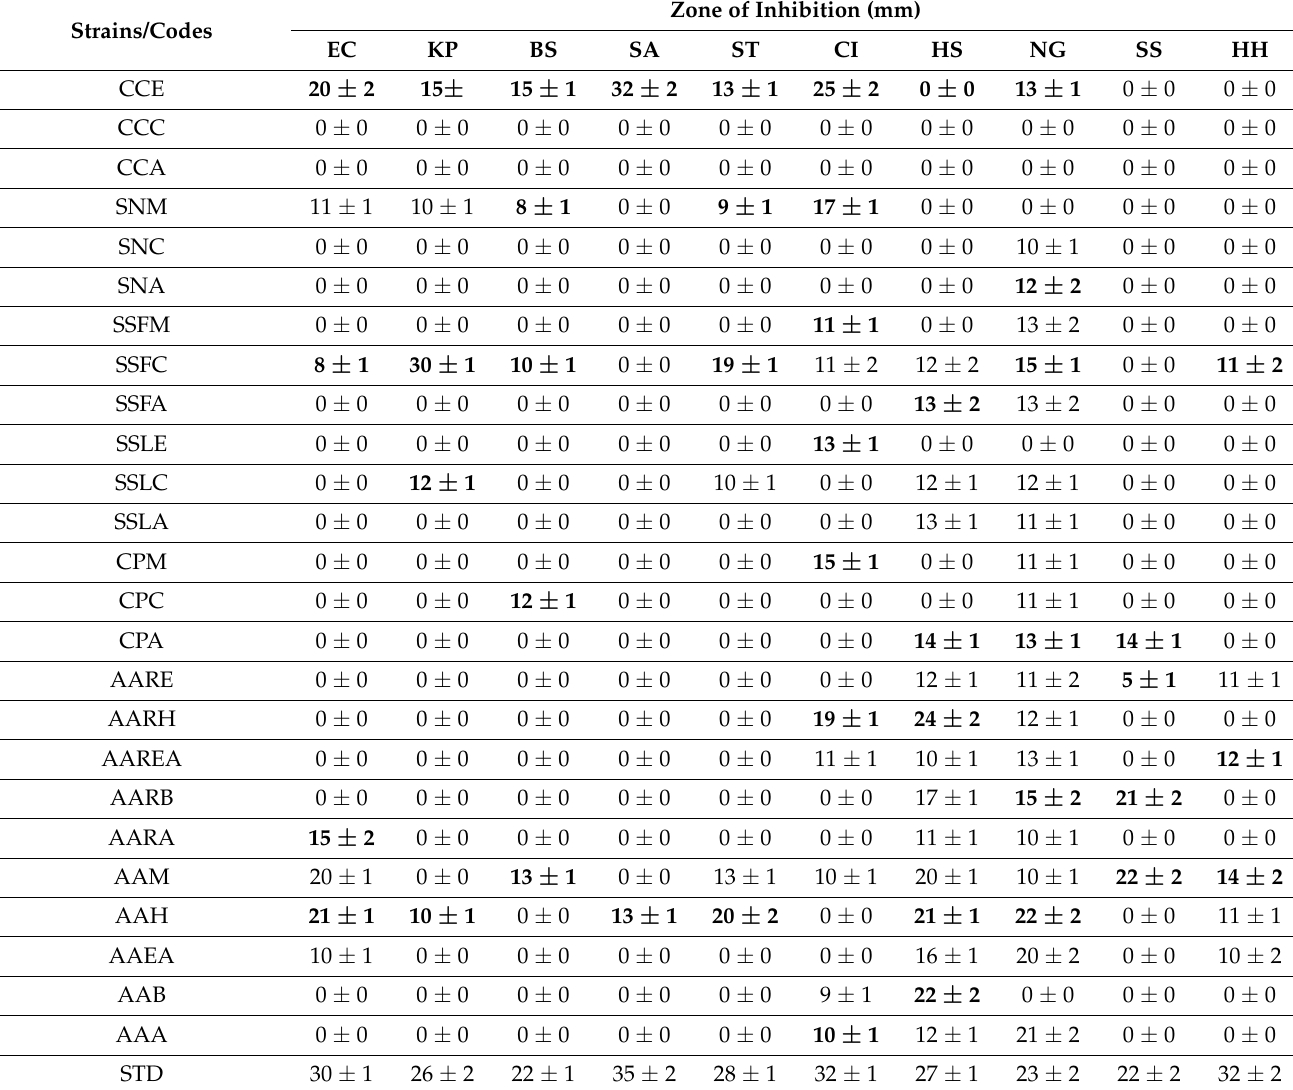
Table 6. Antibacterial activities shown by different fractions of plant